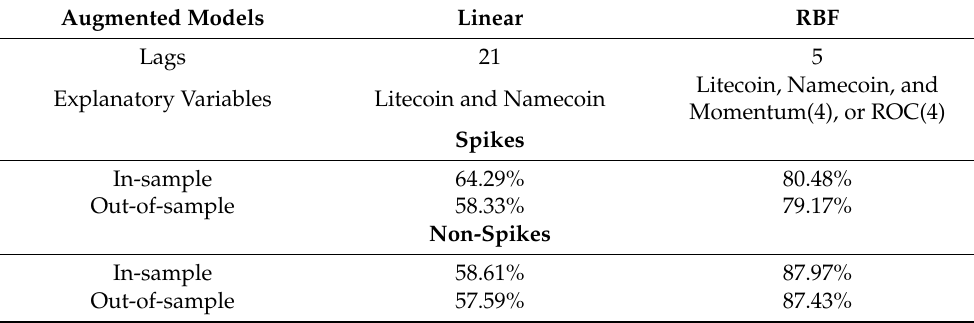
Table 5. Augmented models, per-class accuracy.